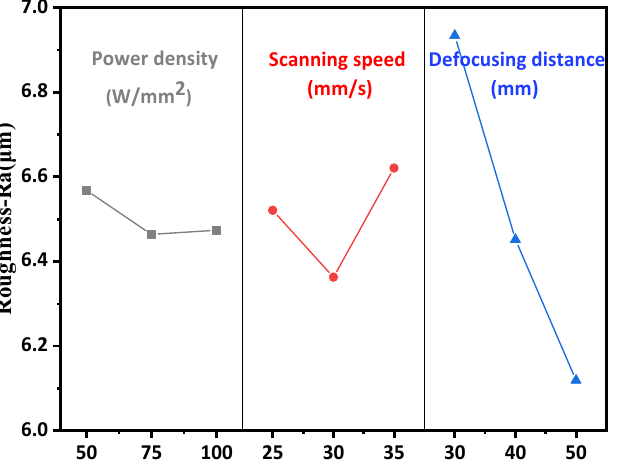
Figure 4. Effect of laser micromelting parameters on surface roughness of Y 2 O 3 coatings.